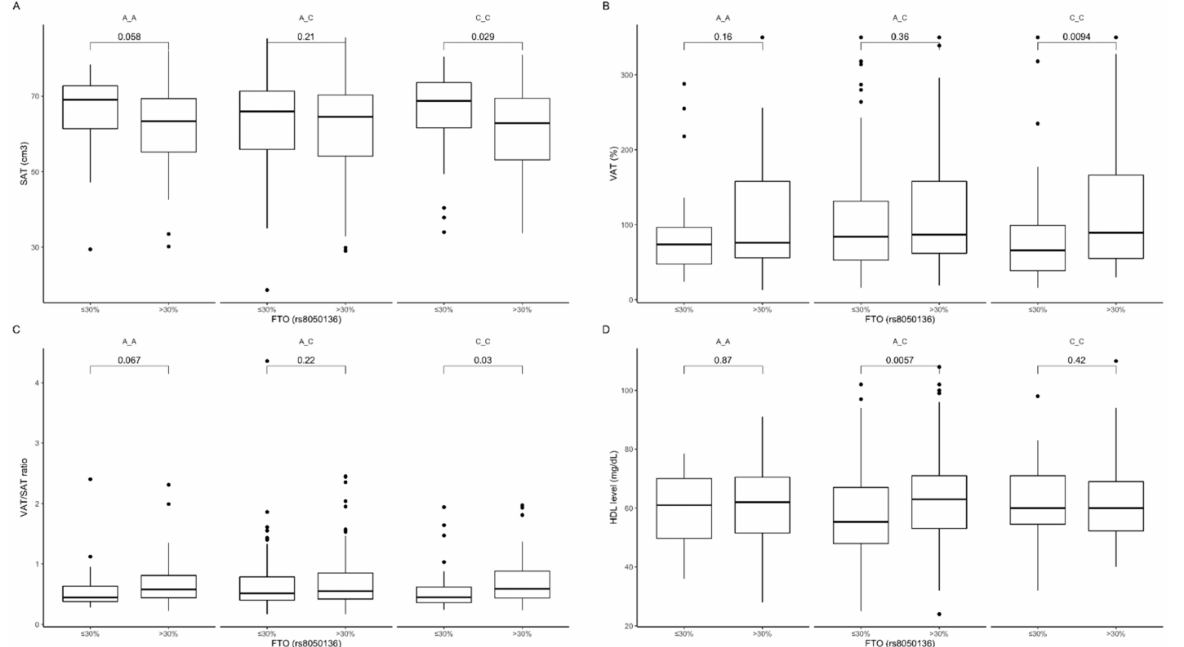
Figure 8. Association of dietary fat intake ≤ 30% and > 30% of total daily energy intake with ( A ) SAT (cm 3 ), ( B ) VAT (%), ( C ) SAT / VAT ratio, and ( D ) HDL level (mg / dL) in FTO rs8050136 genotype